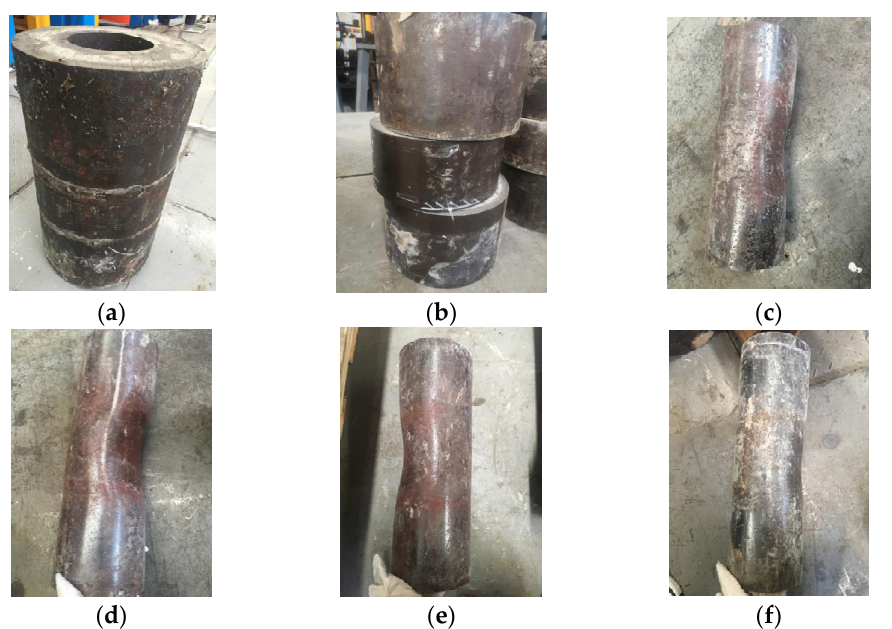
Figure 8. Appearance of cement sheath casing after shear test: ( a ) before cement sheath shear test; ( b ) After cement sheath shear test; ( c ) #1 cement-sheath casing after shearing; ( d ) #2 cement-sheath casing after shearing; ( e ) #3 cement-sheath casing after shearing; ( f ) 125 ksi cement sheath casing after shearing.